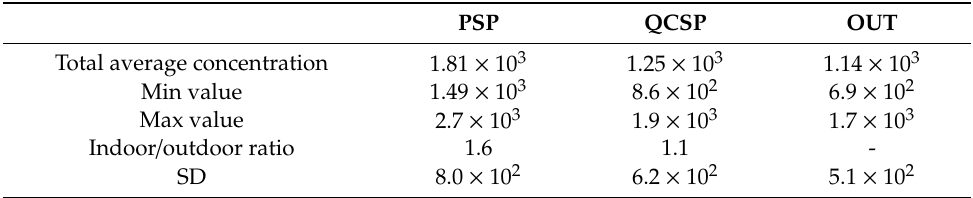
Table 1. Average concentration and indoor / outdoor ratio (I / O), CFU / m 3 of total bacterial colony-forming units per cubic meter of preliminary manual sorting cabin (PSP), purification manual sorting cabin (quality control) (QCSP), and outside the analyzed building